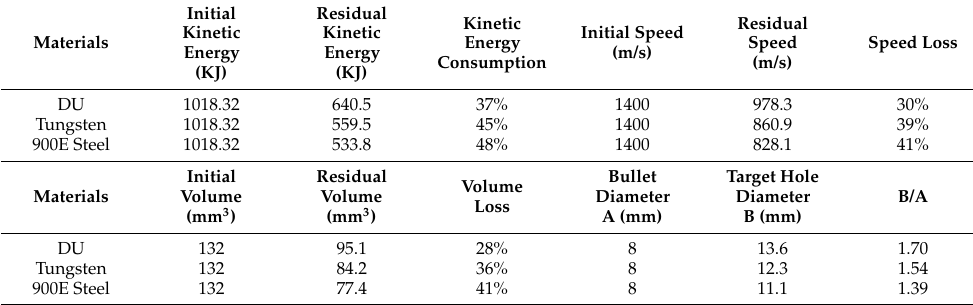
Table 2. Relevant parameters of bullets made of different alloy materials.